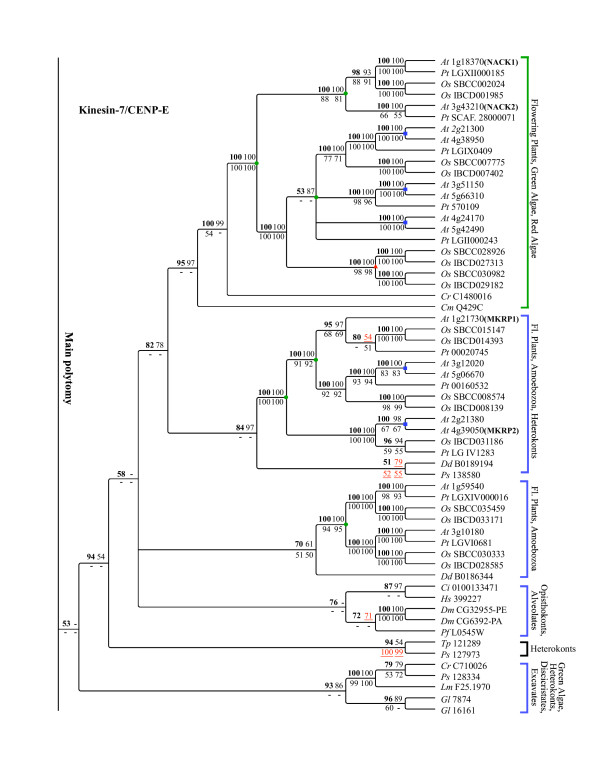
Expanded view of Kinesin-7 family. Expansion of the Kinesin-7 family from Fig. 2. Experimentally studied Arabidopsis kinesins are indicated in parenthesis with their published names in bold. Green brackets indicate plant specific groups, mixed clades are shown in blue brackets and black brackets indicate protozoan species. Green circles, blue squares and a red triangle indicate gene duplications in flowering plants, dicots and monocots, respectively. See Fig. 2 legend for an explanation of support values. For full names of species see Fig. 1 legend. Fl. Plants, flowering plants.